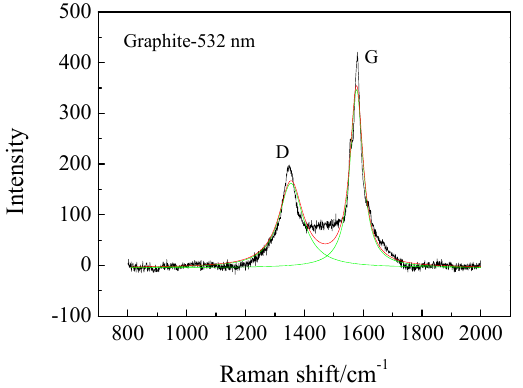
Figure 3. A typical room temperature Raman spectrum of the tested graphite.